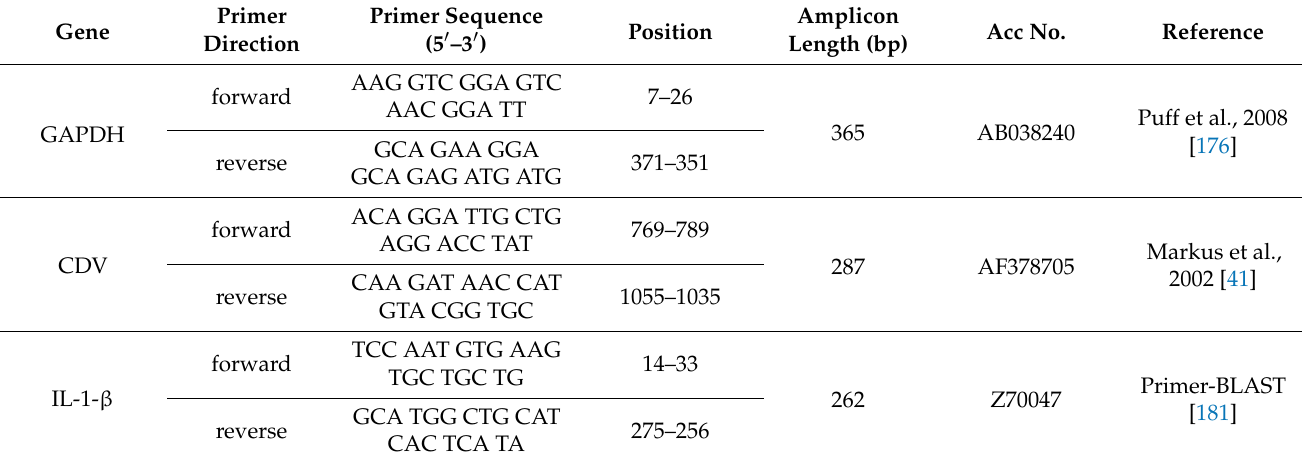
Table 3. Primers used for qualitative RT-PCR for generation of standard dilutions. Gene